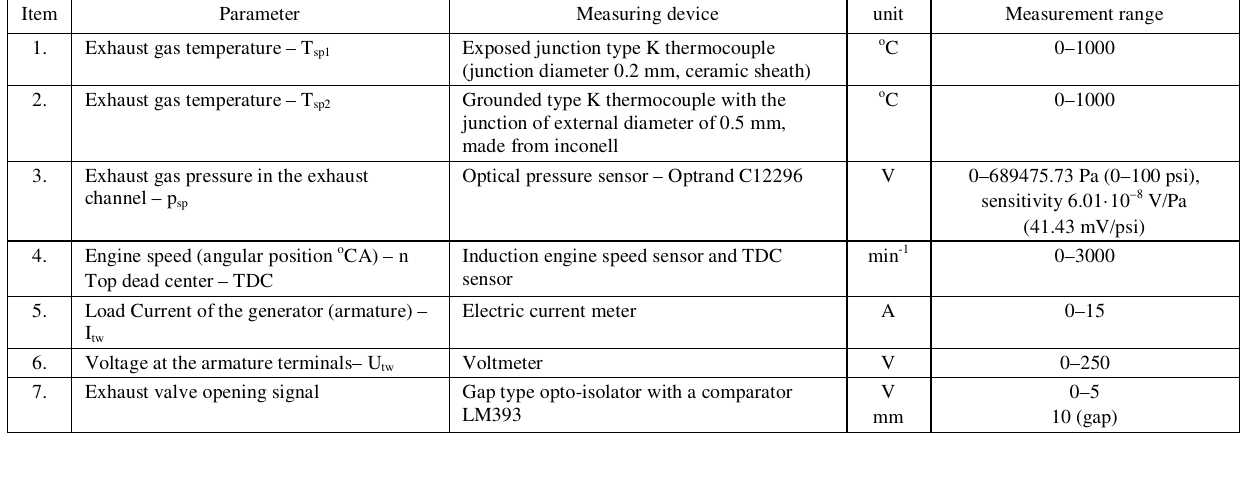
Table 1. The parameters of the Farymann D10 single cylinder diesel engine recorded on the laboratory test